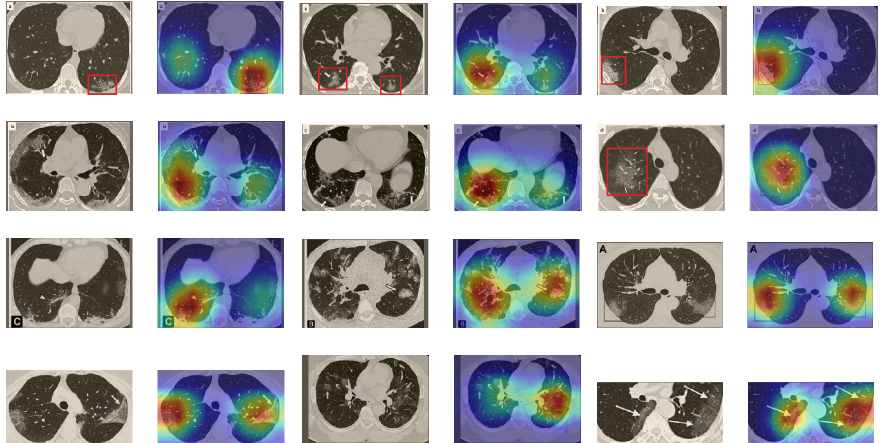
Figure 15. Examples of CT images taken from these two publications [61,62]. The CT images were correctly classified as COVID-19 cases, and the abnormal regions are accurately detected as in the localization